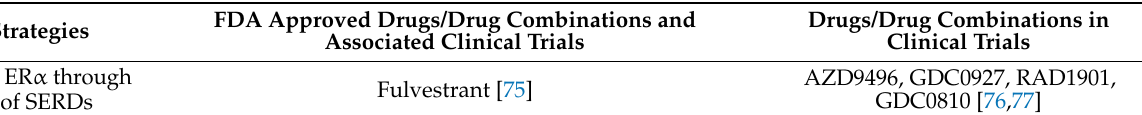
Table 2. Combination therapies for anti-estrogen resistant breast